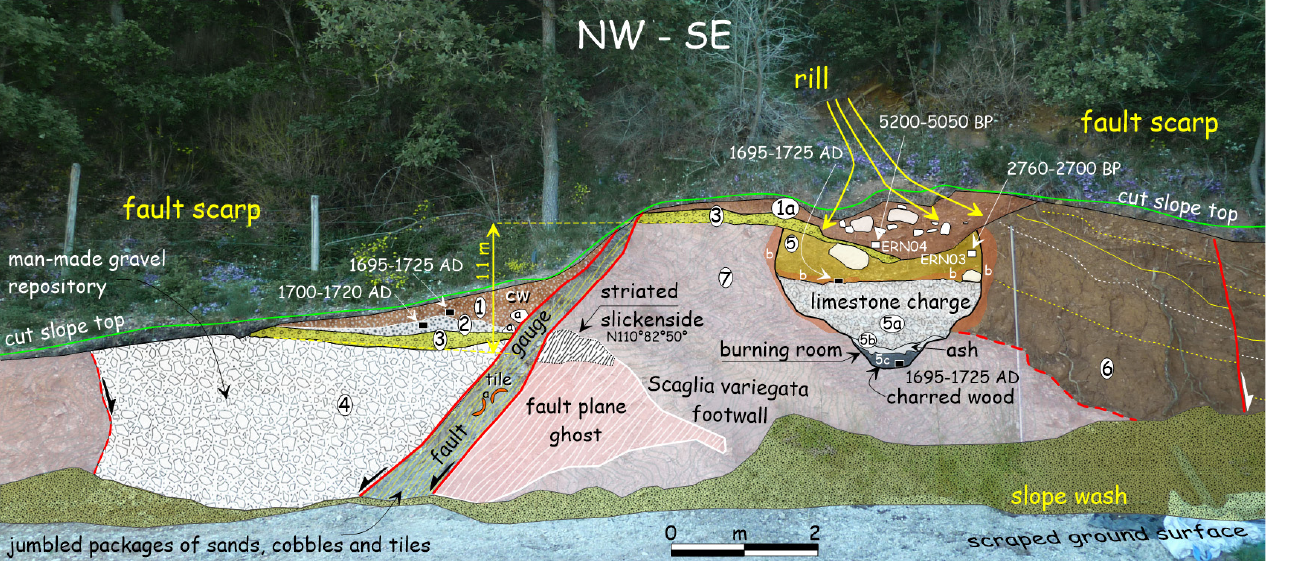
Figure 7. View looking northeast of the limekiln outcrop paralleling the Norcia master fault (see also Figure 4). Legend: 1: sandy gravel (colluvial wedge); 1a: sandy coarse gravel with boulders (channeled debris flow); 2: open-work gravel with charcoals and tiles; 3: yellowish gravel (traction-carpet sheetflood debris): 4: man-made stones heap; 5: sandy seal of the kiln; 6: slope colluvia; 7: Scaglia variegata Formation. The vertical yellow arrow suggests the real offset value of Unit 3 bottom (1.1 m), which appears larger than 2 m in this sketch without the slope correction (see text).